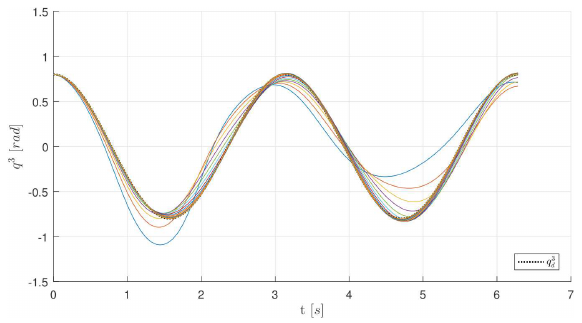
Figure 19. Trajectory tracking q 3 through iterations – set 3